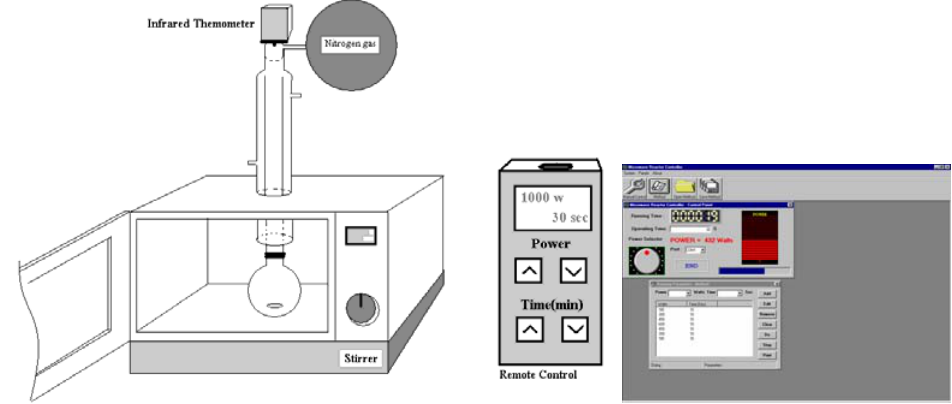
Figure 1. A modified commercial domestic microwave oven, control box and